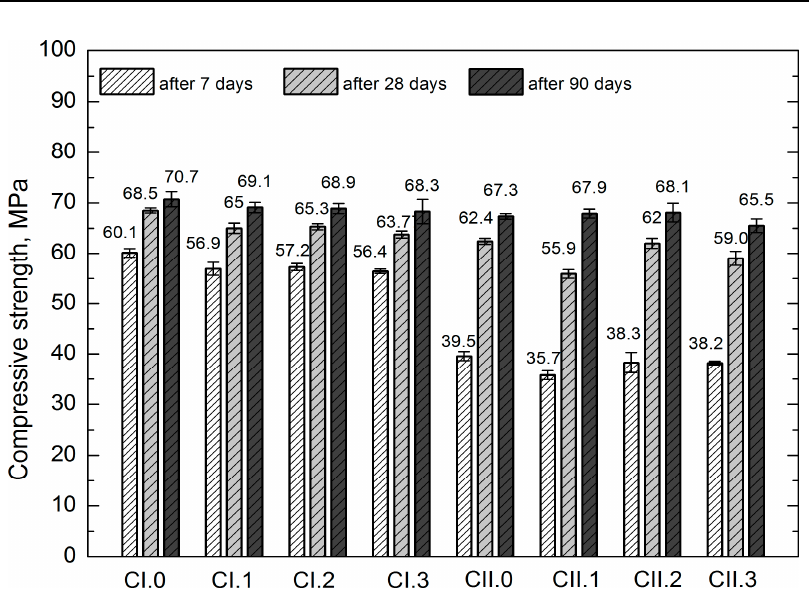
Figure 5. Compressive strength of concrete, f c,cube #150 .